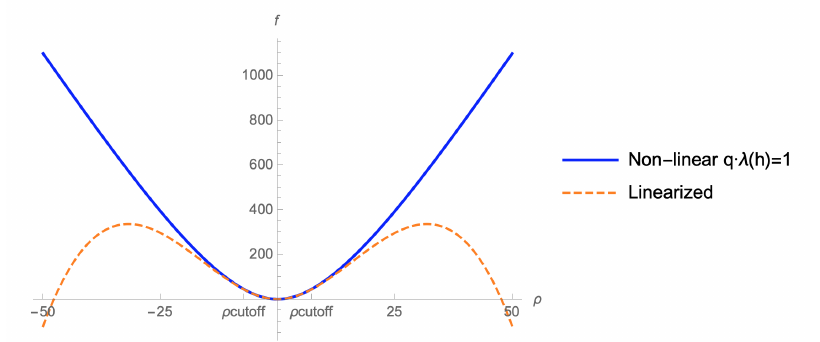
Figure 4 . Solutions of f ( ρ ) with parameters G N q 2 initial condition is R (0) = 17 . For these parameters we expect agreement up to ρ cutoff = 7 . 2 . We see that for larger ρ the linear solution starts to deviate, and even becomes negative. Of course, in this region the RN AdS black hole